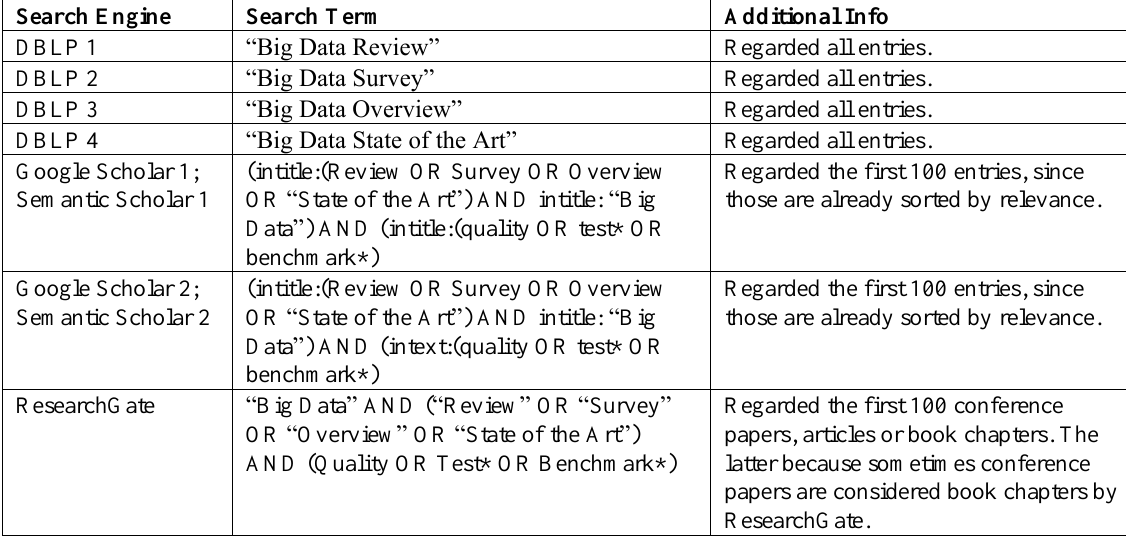
Table 3. Details of the Additional